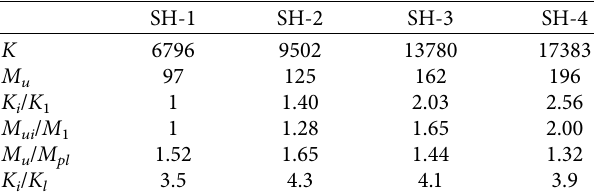
Table 7: Performance with different beam heights (mm).